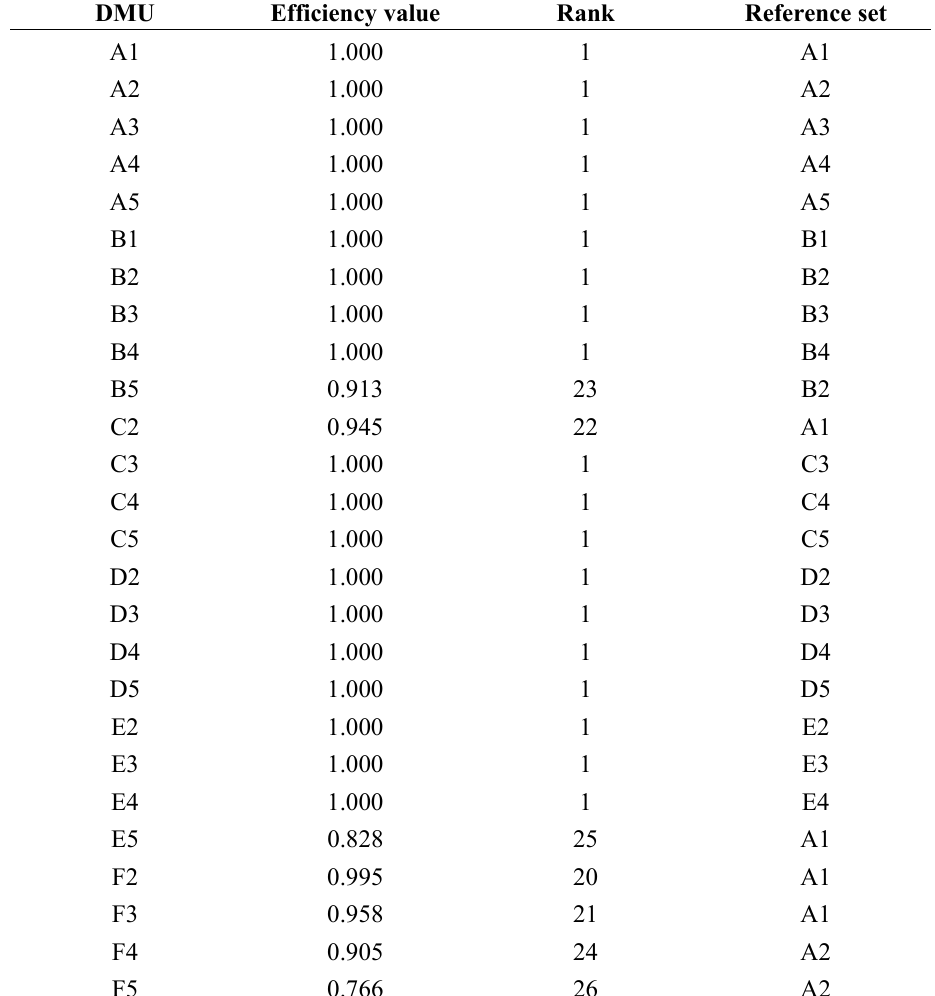
Table 4. Relevant results for